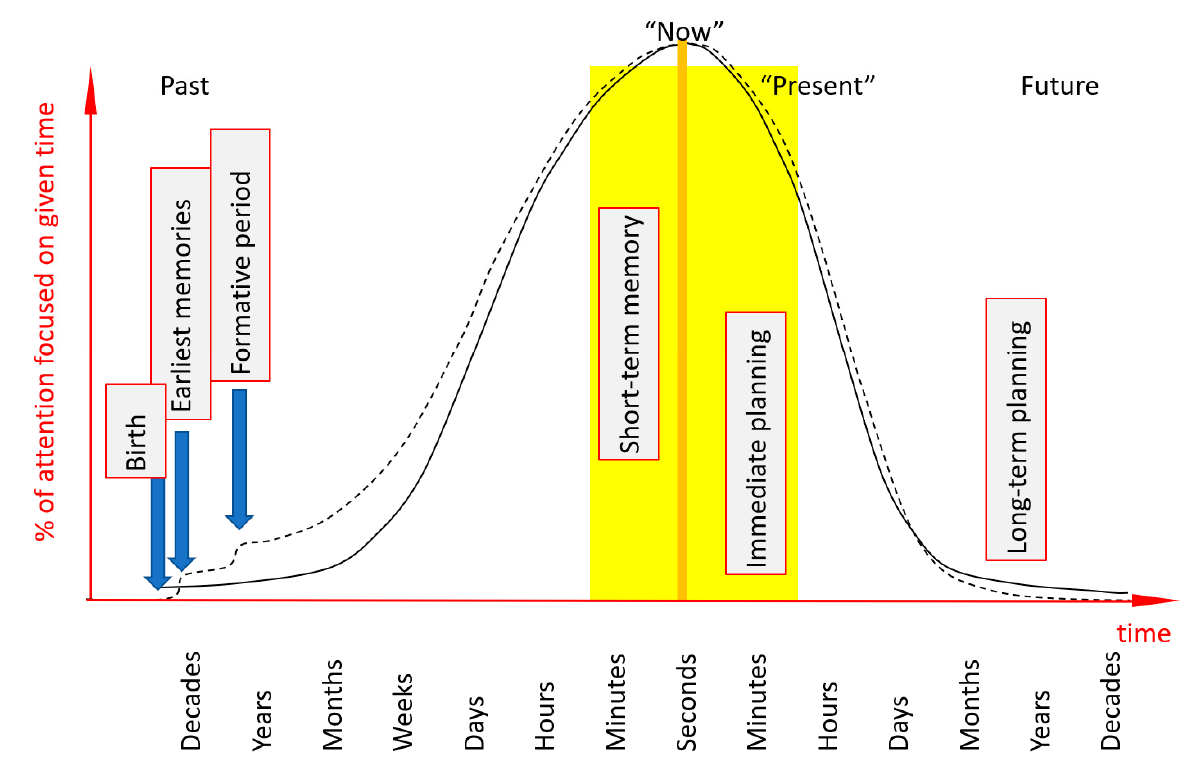
Figure 1. Defining and measuring the temporal focus of attention. A default log-linear distribution (Crovitz and Schiffman 1974), with less and less time dedicated to more and more distant time periods into the past and future (solid line), can be adjusted slightly to accommodate the absence of memories from a very young age and possibly one or more formative periods (Thorne 2000), when more memories than expected are recorded (dashed line).